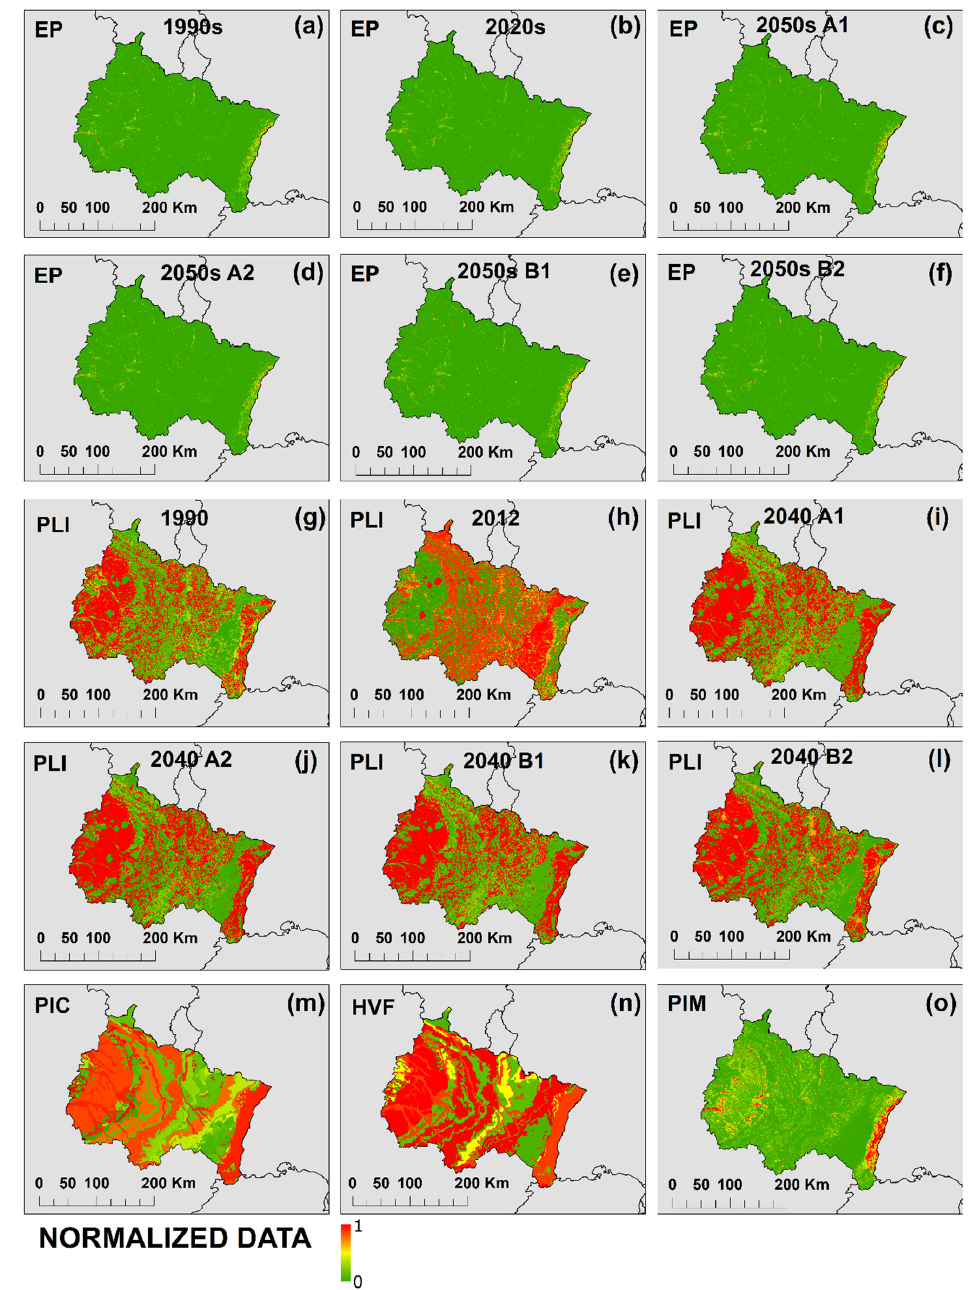
Figure 6. Normalization layers of effective precipitation (EP) ( a – f ), pollution load index (PLI) ( g – l ), potential infiltration coefficient (PIC) ( m ), hydrogeological vulnerability factor (HVF) ( n ), and potential infiltration map (PIM) ( o ) in the Grand Est region.